Question: How would you classify this visualization?
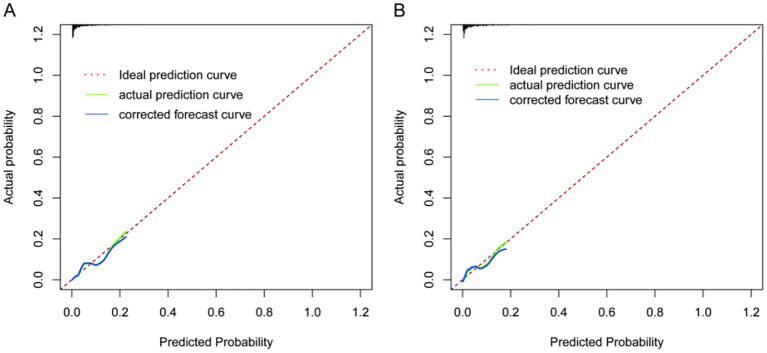
Answer: line